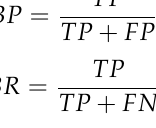
Figure 10. ( a ) Real SAR image SI 6 ; ( b ) the ground truth of SI 6